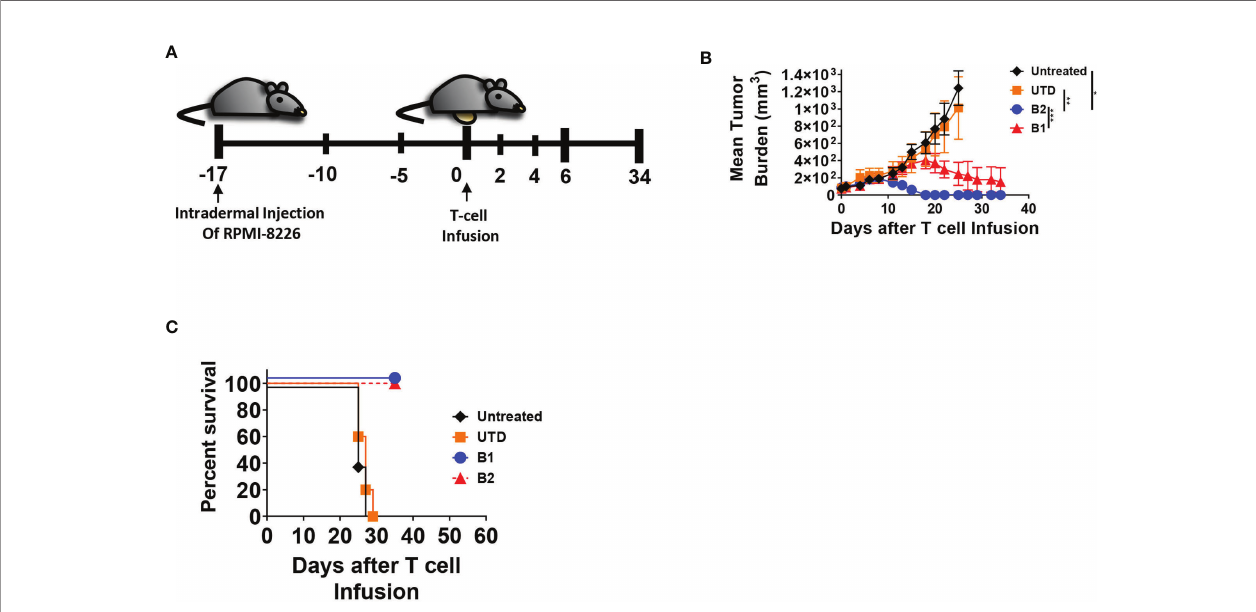
FIGURE 2 | B2 CAR T-cells are more potent in eradicating tumors in vivo compared to B1 CAR. (A) In the in vivo tumor model, 8 x 10 6 RPMI-8226 cells were intradermally injected on the abdomen of NSG mice (all groups n = 8, except untreated, n = 5) and allowed to engraft for 17 days before the intravenous injection of T-cells. Five million CAR T-positive -cells was infused per mouse, normalized based on CAR expression, or equivalent amount of non-transduced T cells (UTD), or left untreated. Mice were monitored for (B) tumor growth and (C) survival. Statistical signi fi cance was determined by paired Student t-test for the indicated groups, *p<0.05, **p<0.01,